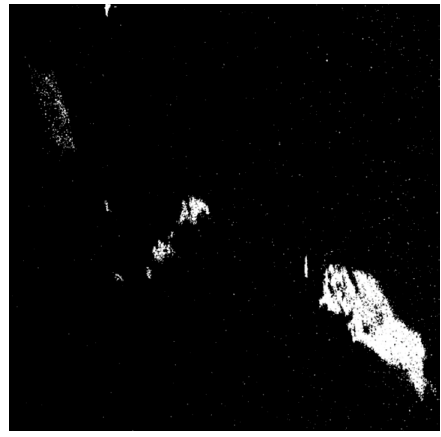
Figure 7. Classification result achieved by SAE, 0 stands for nonoil and 1 stands for mineral oil.